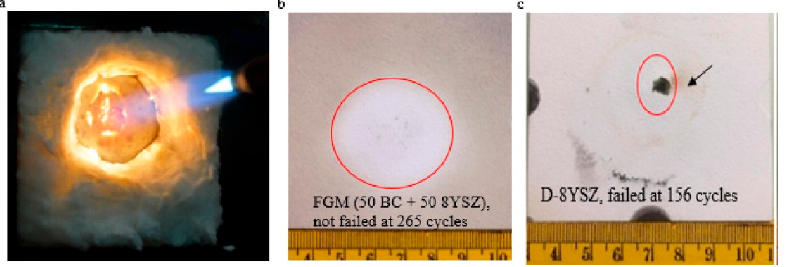
Figure 24. Photographs of ( a ) TBC under thermal gradient test at 1200 °C ( b ) FG-TBC not failed at 265 cycles ( c ) traditional 8YSZ cracked at 156 cycles [150] .